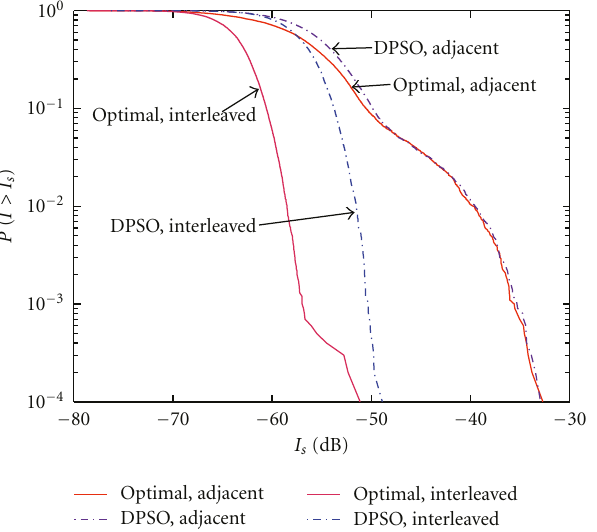
Figure 9: Optimal PTS-AIC and DPSO PTS-AIC, N b = 8, N w = 4. P = 30, Q = 20.